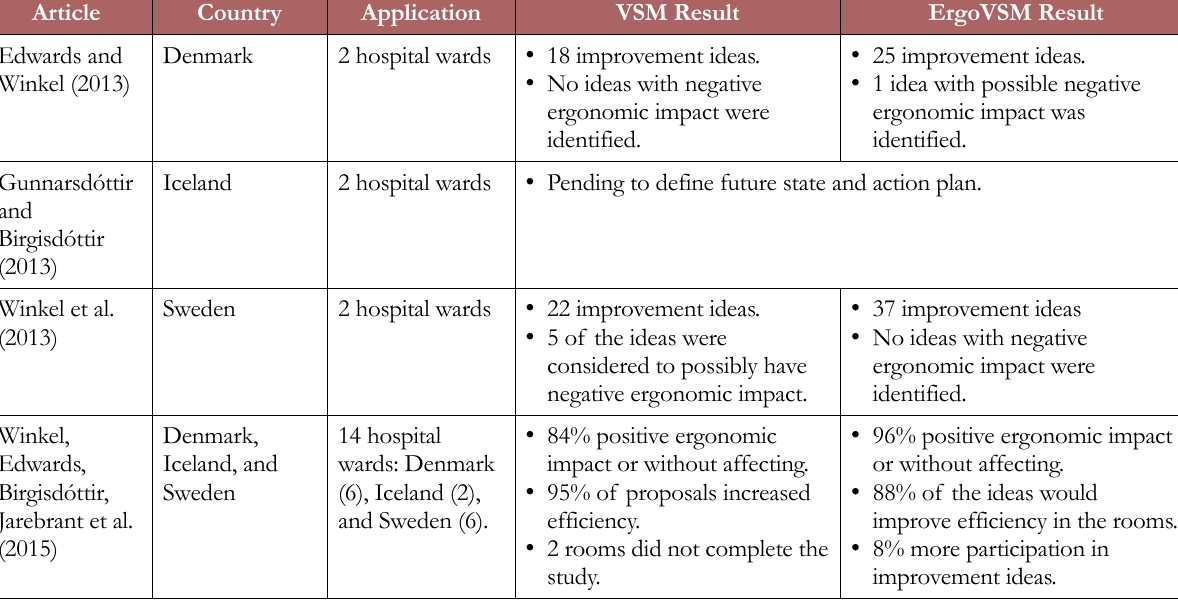
Table 3. Comparative of VSM against ErgoVSM in hospital